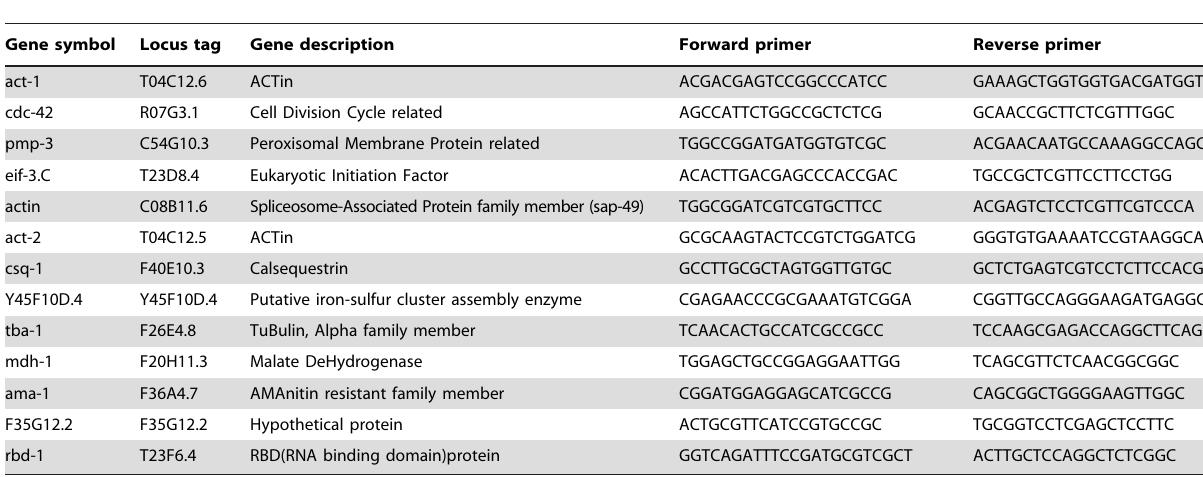
Table 1. Primer Information of Selected Candidate Reference